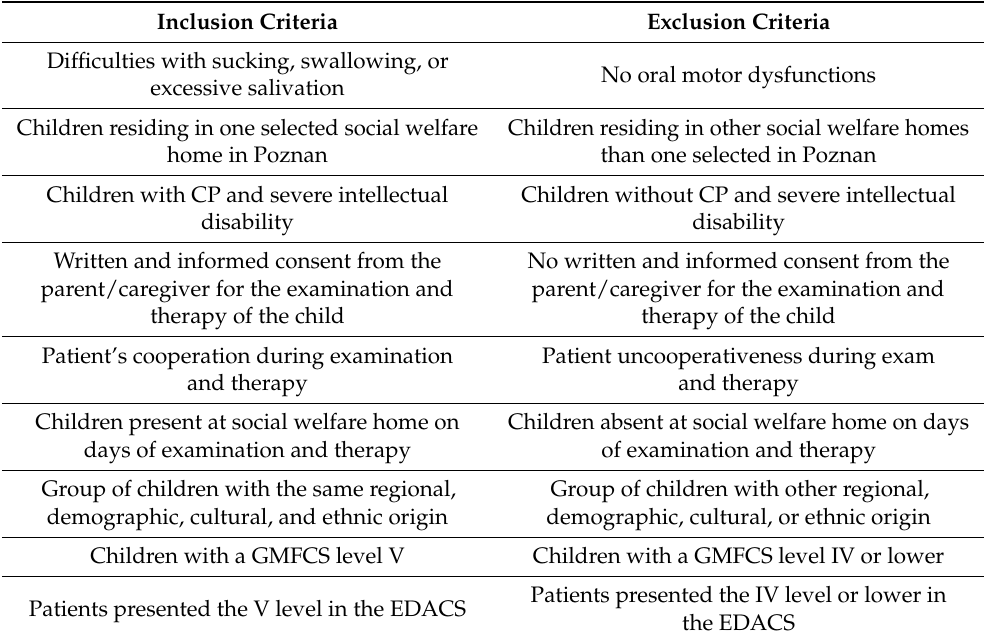
Table 1. Inclusion and exclusion criteria for participants diagnosed with cerebral palsy. Inclusion